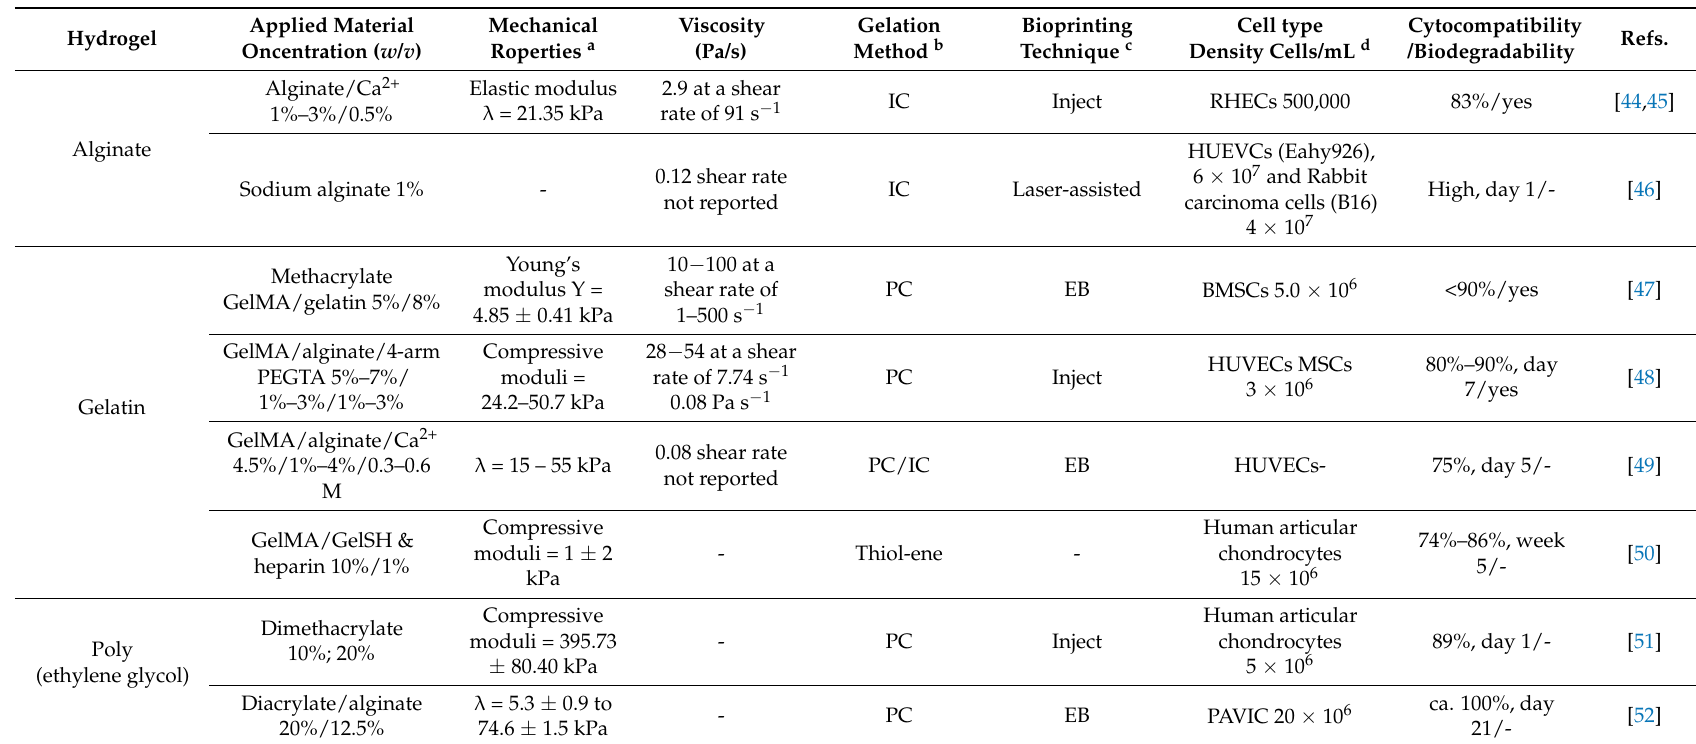
Table 1. Properties of different hydrogels used in 3D